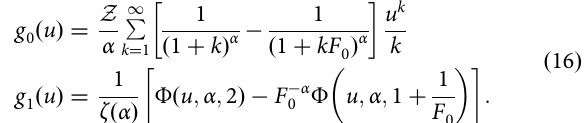
The analytical calculations are compared with simulations in Fig. 4b. We keep the radius of interaction r constant and discuss the results as a function of the number of nodes in the